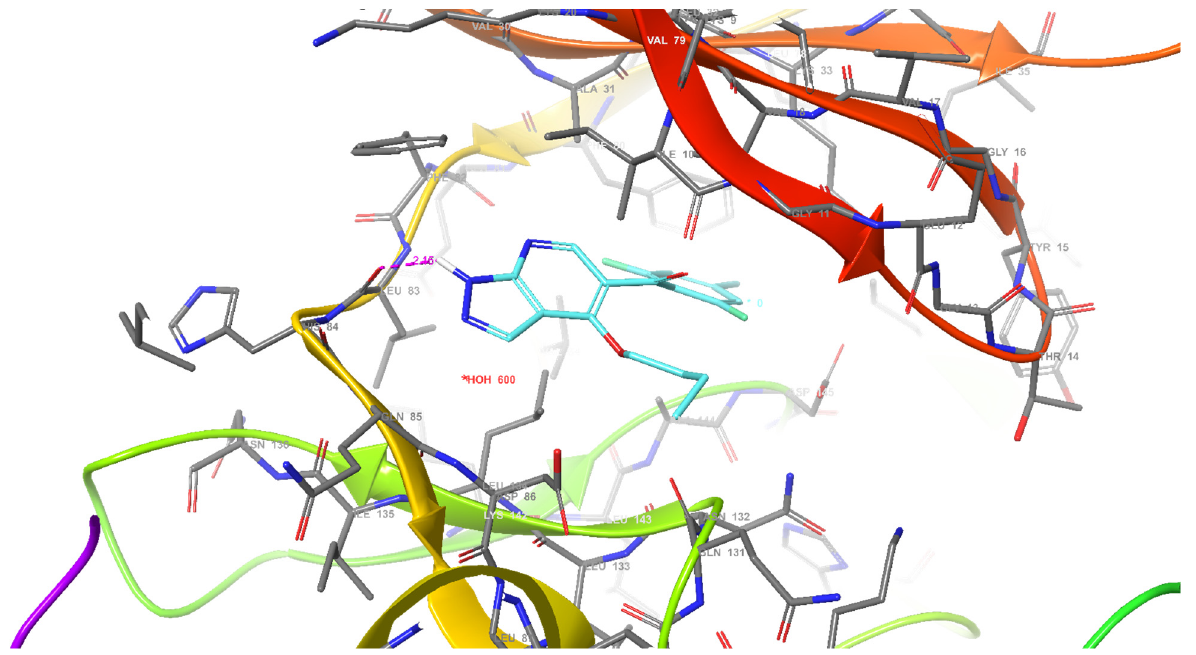
Figure 7. Three-dimensional binding interactions of BMS-265246 within the ATP binding pocket of CDK2. Hydrogen bond (purple dotted line), hydrogen atoms (white), nitrogen atoms (blue), fluorine atoms (light green), and oxygen atoms (red).